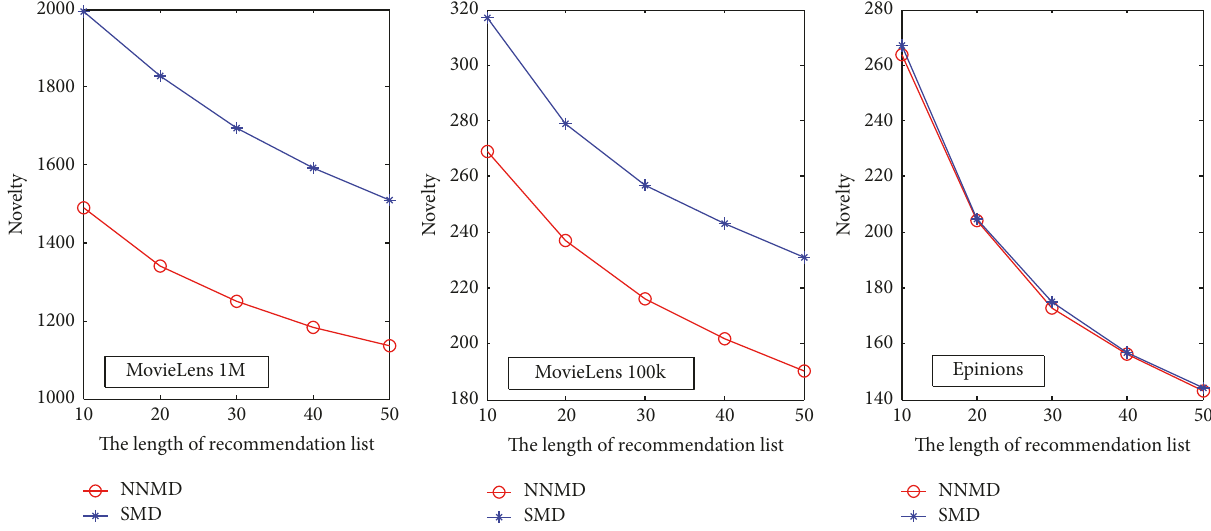
Figure 6: The novelty of NNMD and SMD algorithm in MovieLens 100k, MovieLens 1M, and Epinions under different length of recommendation list. The parameters for the NNMD algorithm are 𝑁 = 50 and 𝛼 = 0.9 in MovieLens 100k and MovieLens 1M, while they are 𝑁 = 10 and 𝛼 = 0 in